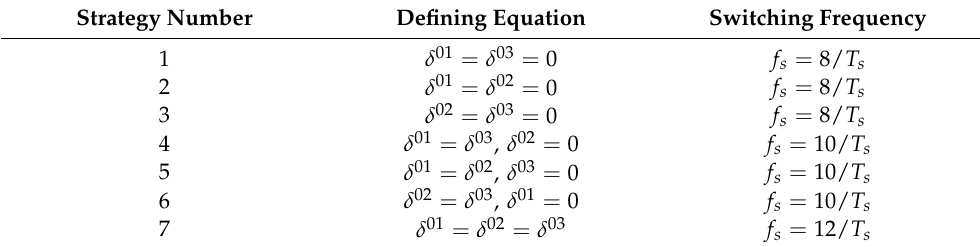
Table 5. Strategies for zero switching states and respective switching